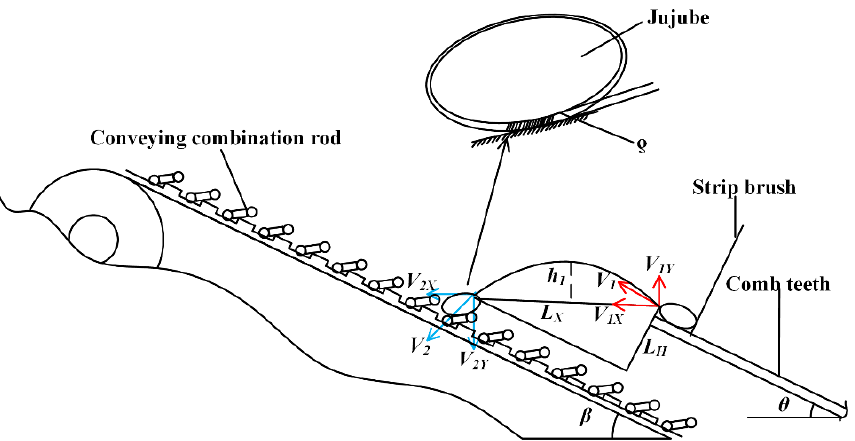
Figure 7. Collision diagram of jujube and conveying combination rod.